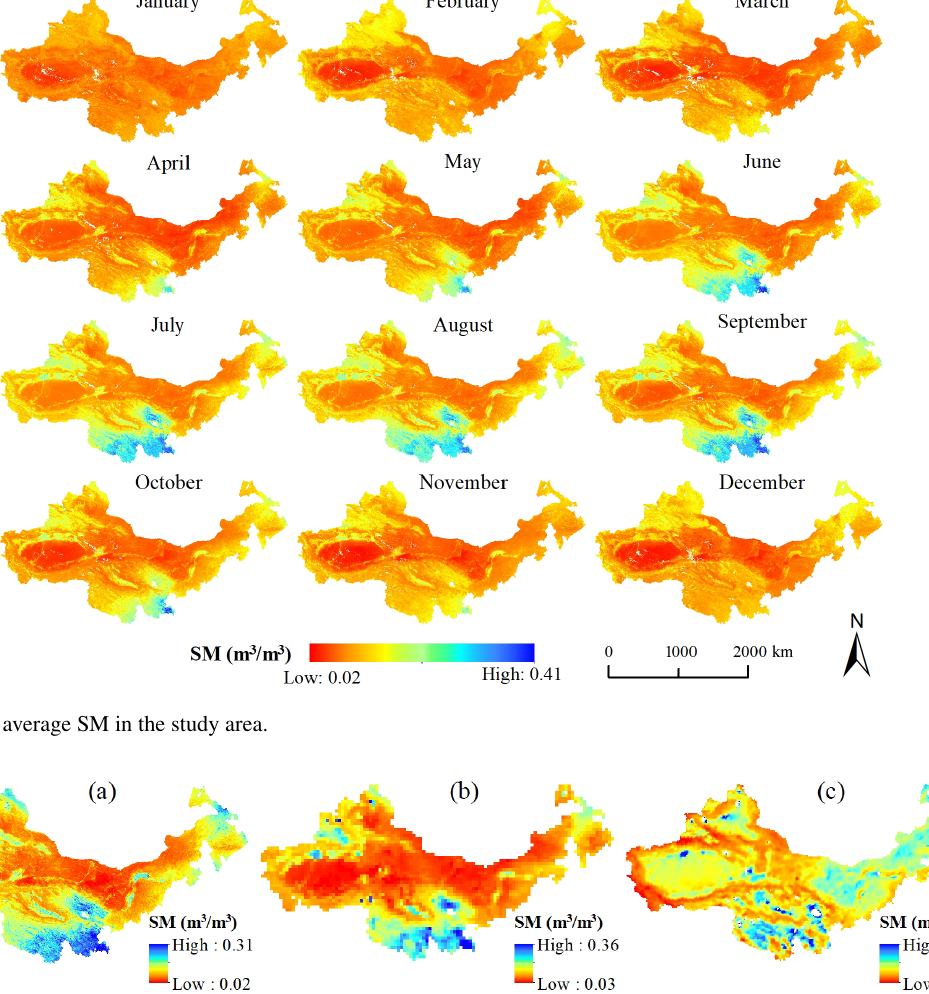
Figure 10. Monthly average SM in the study area.